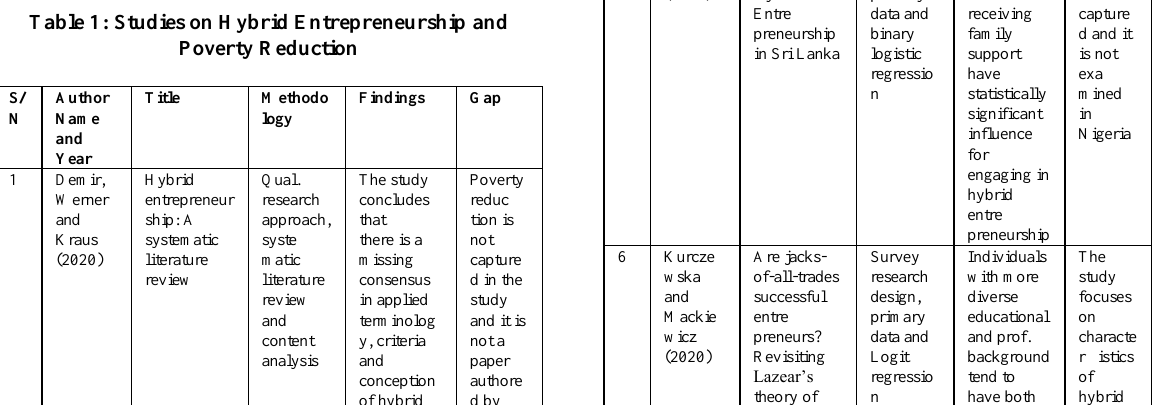
Table 1: Studies on Hybrid Entrepreneurship and Poverty Reduction